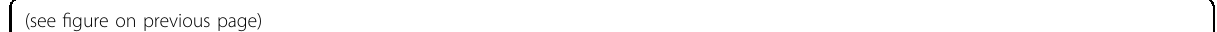
Fig. 6 The pro-in fl ammatory macrophage subpopulation is a predominant source of most detrimental molecules in the development of TAAD. a Split violin plot showing the expression of genes encoding MMP family proteins in the mouse aorta of the BAPN and CTRL groups. scRNA- seq data from all three time points were considered. Log2 transformation was performed on the y-axis. CTRL control. b Experimental procedure for bulk RNA-seq of the aorta tissues from TAAD patients ( n = 8) and healthy donors ( n = 6). c Principal component analysis showing the separation of the TAAD from the healthy group. d The expression of the markers of the three macrophage subpopulations and three MMP genes in aorta tissues from TAAD patients and healthy donors. The statistical threshold of the differential expression test was set to be a q value < 0.05. e Experimental procedure for bulk RNA-seq of CD11b + aortic cells, CD11b − aortic cells, and CD11b + PBMCs from TAAD patients ( n = 4). f The expression of the markers of the three macrophage subpopulations in CD11b + aortic tissues and corresponding CD11b + PBMCs. g The expression of the markers of the three macrophage subpopulations and three MMP genes in CD11b + and CD11b − aortic cells from TAAD patients and healthy donors. The statistical threshold of the differential expression test was set to be a q value <